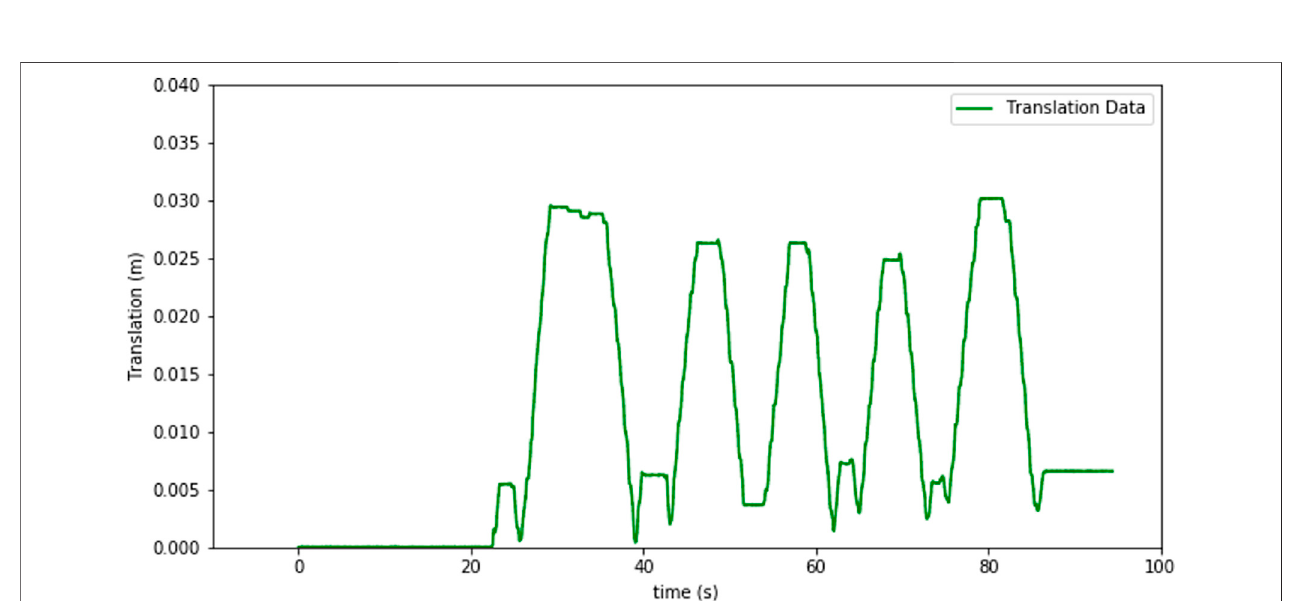
FIGURE 7 | Instrument tip force computed based on the force-torque sensor signal.